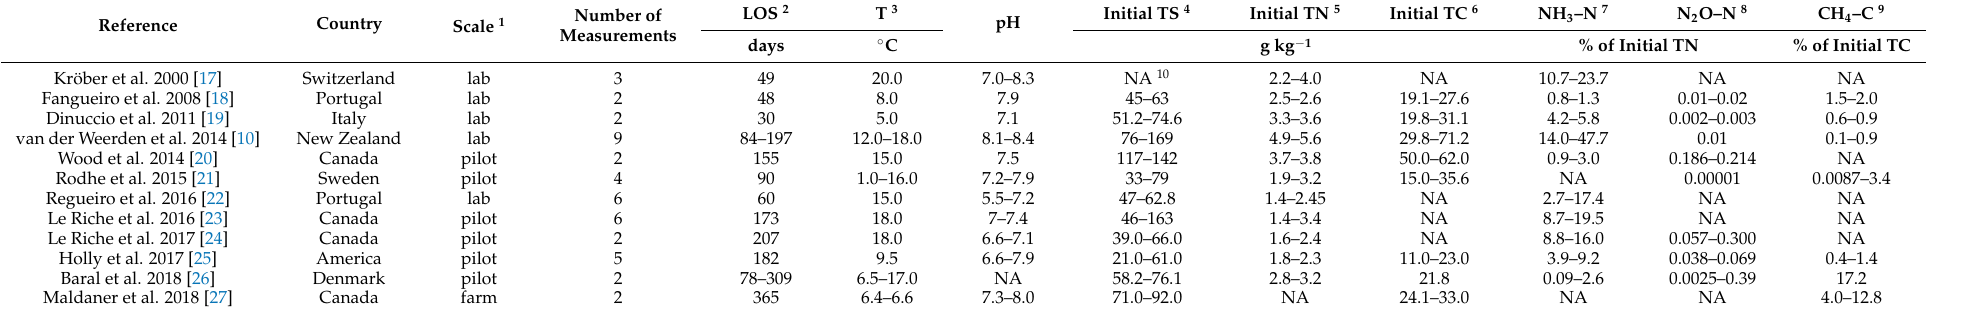
Table 1. Detailed information of the 12 selected articles for extracting